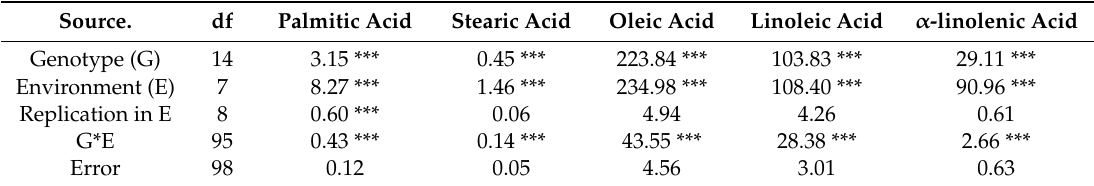
*** Significant at the 0.001 probability level.